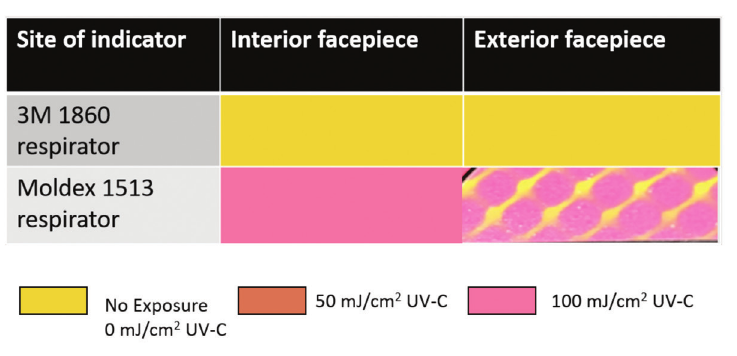
Figure 5. Pictures of ultraviolet-C (UV-C) light colorimetric indicators placed on the interior and exterior facepiece surfaces of Moldex 1513 and 3M 1860 respirators to assess penetration of UV-C from the ARK UV-C box through the full thickness of the respirator material. Yellow, no UV-C exposure; orange, UV-C dose 50 mJ (ie, adequate to kill vegetative bacteria); pink, UV-C dose 100 mJ (adequate to inactivate Clostridioides difficile spores). The color changes demonstrate penetration of UV-C through all layers of the Moldex 1513 but not the 3M 1860